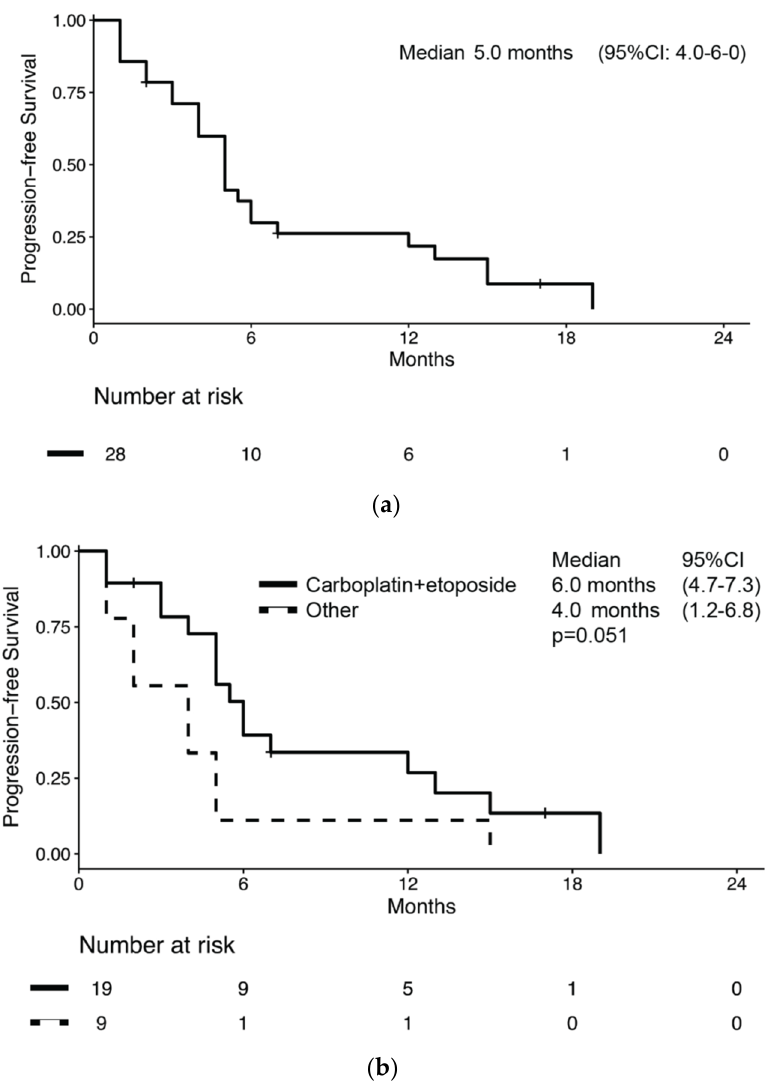
Figure 3. Kaplan–Meier estimates of progression-free survival (PFS) in bladder NEC patients who received chemotherapy for metastatic disease ( a ) overall and ( b ) by chemotherapy regimen received.